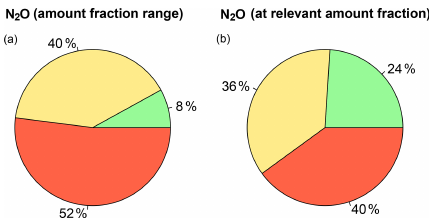
Figure 6. (a) Percentage of the results of the sixth round-robin experiment that were for the range of the relevant amount frac- tion ± 5nmolmol − 1 within the WMO/GAW network compatibility goals (green), the extended network compatibility goals (yellow), or outside the network compatibility goals (red area). (b) Same as (a) but at the relevant amount fraction (see text for